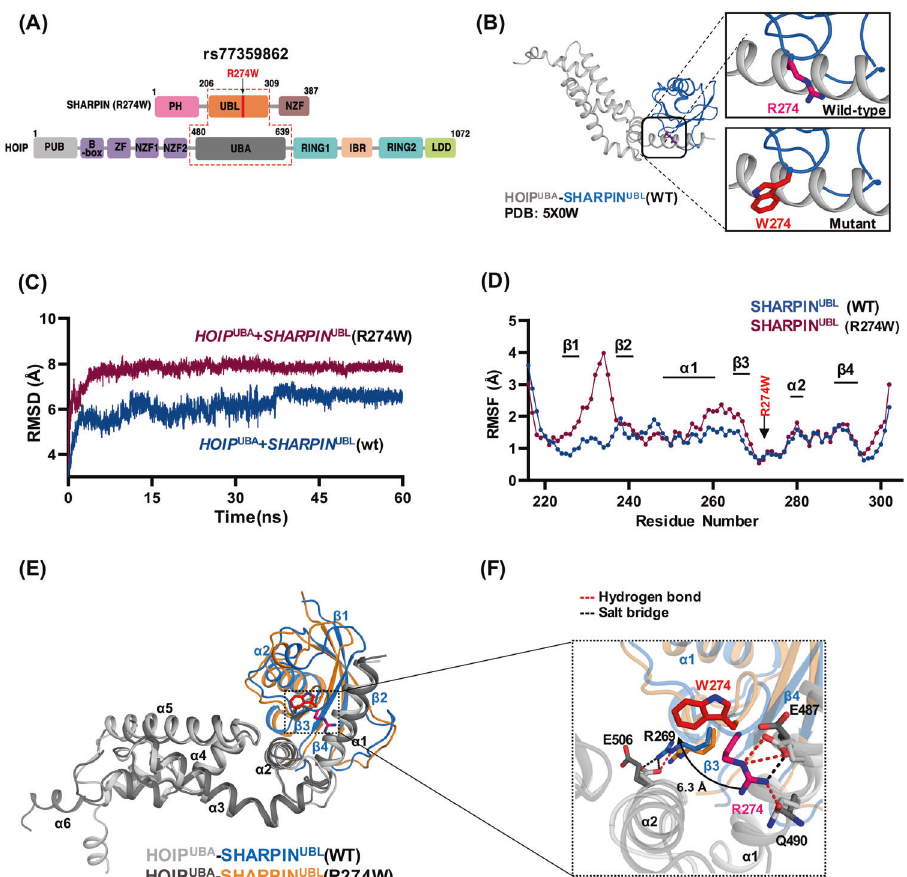
Fig. 3 Molecular dynamics simulation modeling of the effect of the SHARPIN R274W mutation on the HOIP UBA -SHARPIN UBL complex. A Domain map of SHARPIN and HOIP proteins. Protein binding occurs at the HOIP UBA and SHARPIN UBL domains. B Crystal structure of the HOIP UBA -SHARPIN UBL (PDB: 5X0W) binding complex indicating the location of the SHARPIN R274 residue in the wild type (WT) and manually mutated W274. C The root mean square deviation (RMSD) plot indicates the overall global deviation of the protein complex during 60 ns in WT and mutant. D The root mean square fl uctuation (RMSF) plot shows the fl uctuations of each residue of the SHARPIN (R274W) in complex during the last 20 ns of the equilibrated run. The structural elements corresponding to those residues were indicated above the plot. E Structural alignment of the structures obtained by averaging the atomic coordinates of the last 20 ns of the simulated run between WT complex and the mutant complex. The color code is maintained throughout the fi gure as per the legend between HOIP UBA -SHARPIN UBL WT and R274W mutant protein complexes which are represented as cartoons and the residues in stick representation. The structural elements were marked starting from N-terminal ends of the protein. F The mutation site region is zoomed in from ( E ) (indicated by rectangular box) and the break in salt bridge (black dashed line) and hydrogen bonds (red dashed line) just with respect to the mutation is shown. The deviation of the residue from the WT to the mutant is marked by the arrow and the distance mentioned in